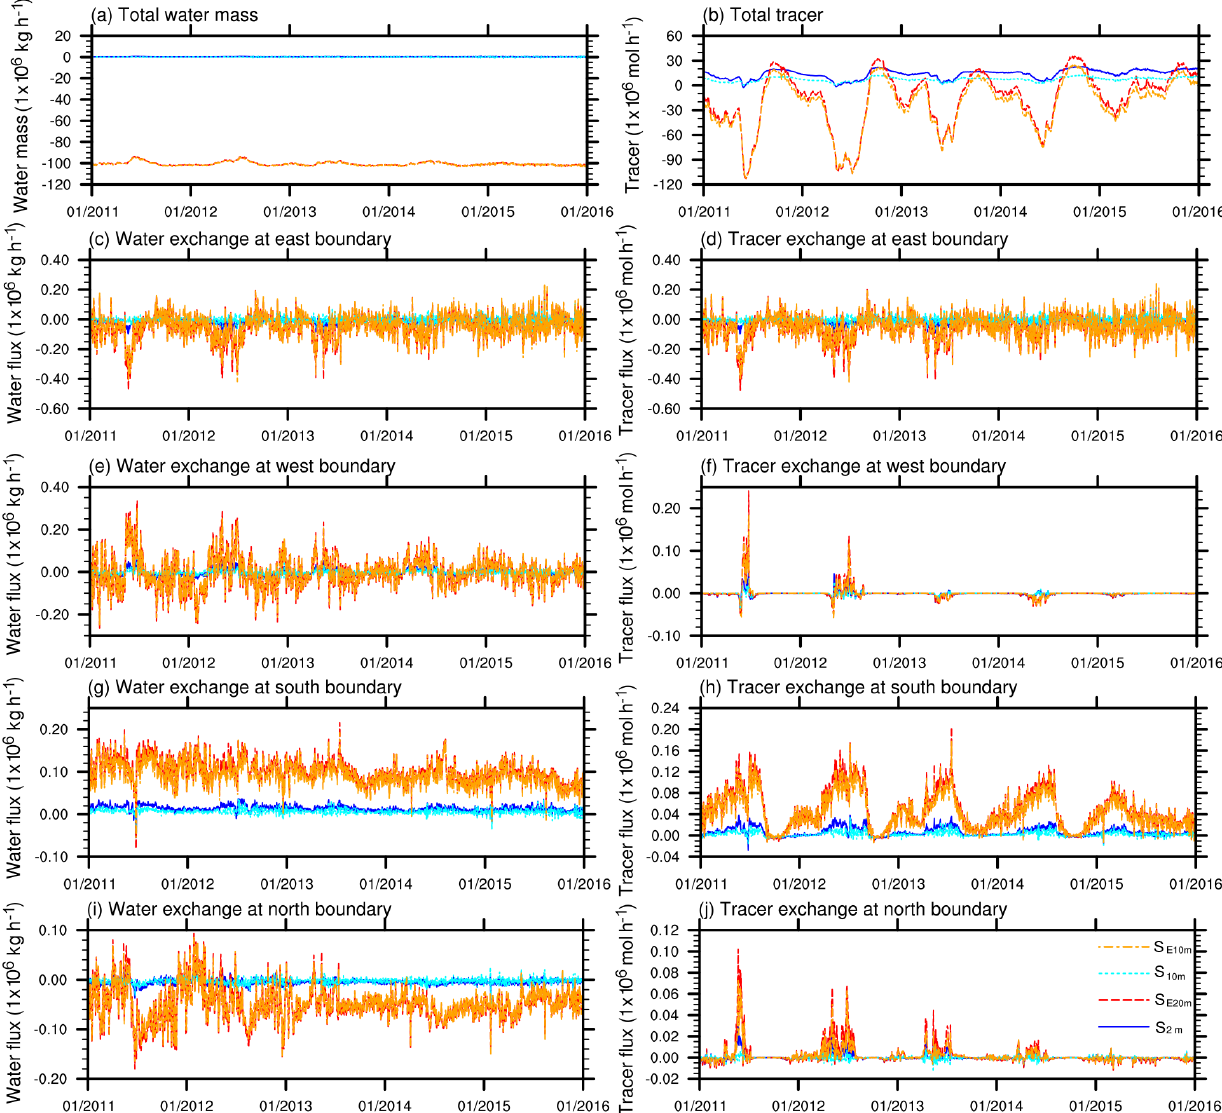
Figure 14. Deviations of total water mass, tracer, and exchange rates of water and tracer at four boundaries from those simulated by S 2m (for S 10m and S 20m ) and by S E2m (for S E10m and S E20m )